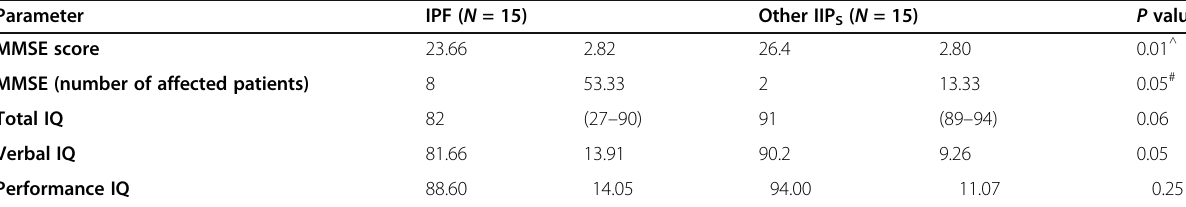
Table 5 Comparison between IPF patients and other IIP S patients